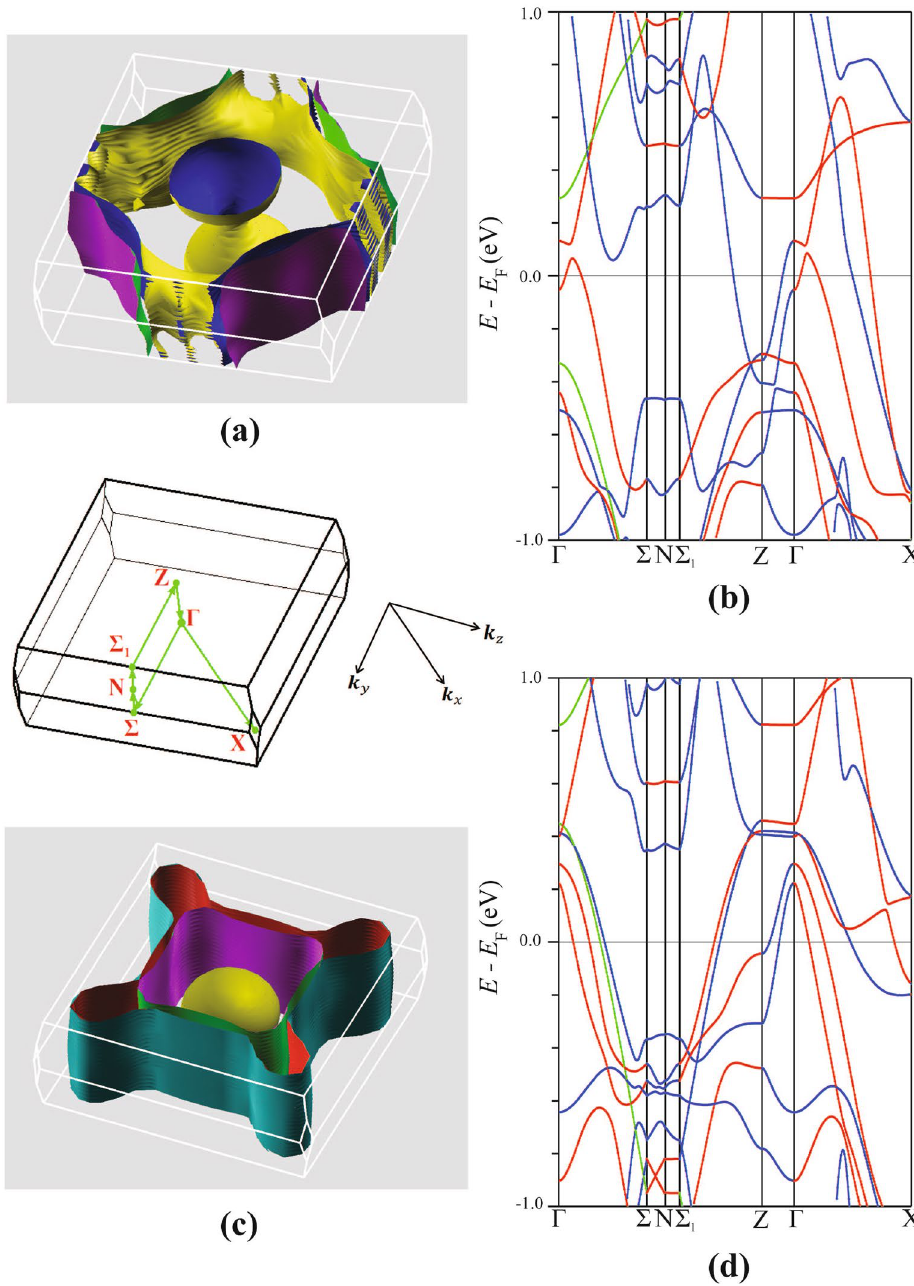
Figure 10. Spin-up ( a ) and spin-down ( c ) Fermi surfaces of EuFeAs 2 . The corresponding near-Fermi energy band structure for spin-up ( b ) and spin-down ( d ) energy bands. The corresponding k -path traversed in the primitive Brillouin zone is shown at the center of the figure. SigmaPlot v14, www. systa tsoft ware.